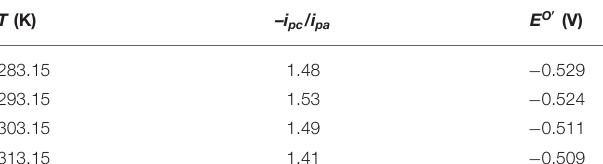
TABLE 3 | The mean values of –i pc /i pa and the formal potential ( E O ′ ) calculated from the CV curves in Figure 7 .